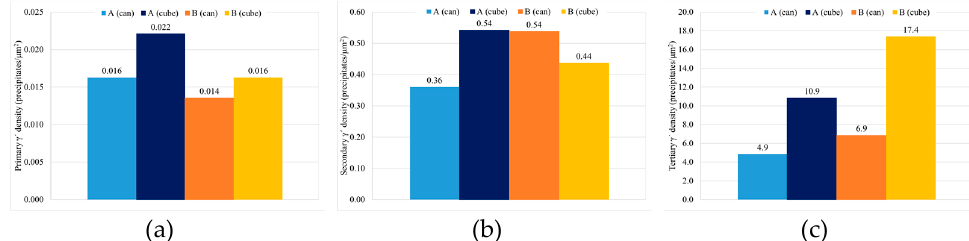
(cid:48) density of precipitates by population ( a ) primary, ( b ) secondary and ( c ) Figure 19. γ′ density of precipitates by population ( a ) primary, ( b ) secondary and ( c ) tertiary. Figure 19. γ Figure 19. γ′ density of precipitates by population ( a ) primary, ( b ) secondary and ( c ) tertiary. Figure 19. γ′ density of precipitates by population ( a ) primary, ( b ) secondary and ( c ) tertiary.